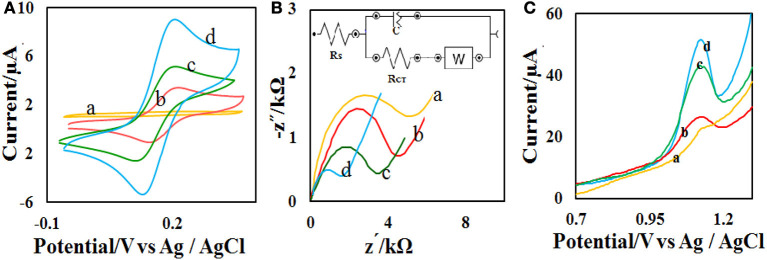
(A) CVs and (B) Nyquist plots of the different modified electrodes in 0.1 M PB containing 5.0 mM [Fe(CN)6]−3/−4 at (a) bare, (b) CdO NP/CPE, (c) Fe3O4 NP/CPE, and (d) CdO/Fe3O4 NP/CPE in the scan rate of 50 mV s−1
(C) The recorded DPVs of the (a) bare, (b) CdO NP/CPE, (c) Fe3O4 NP/CPE, and (d) CdO/Fe3O4 NP/CPE in presence of 50 μM ACV.